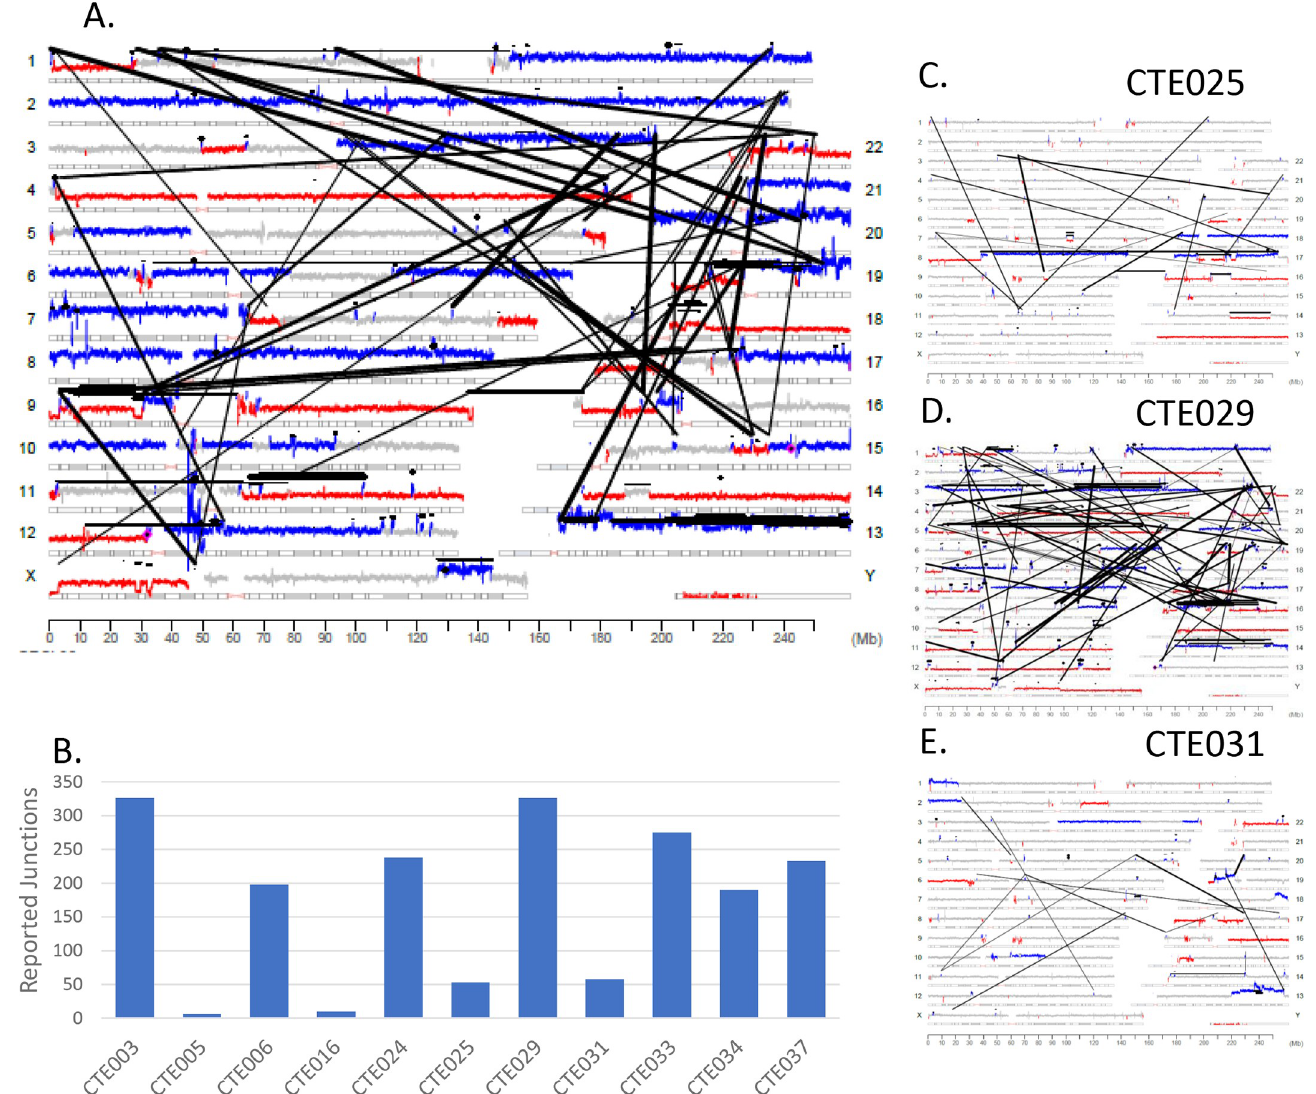
Fig 2. Mate–Pair sequencing results from primary tumor DNA. (A) Genome plot for primary tumor of case CTE024. Chromosomes are listed on the left and right Y–axis’; basepair position is on the X axis. Grey cytobands indicate genomic loci bands. The height of the dots each represents the average number of reads over 30 k bases. Grey color indicates wild–type 2 copy state of DNA, blue indicates gains, red indicates losses. Black dots indicate small intrachromosomal rearrangements, while the black lines indicate interchromosomal rearrangements or larger intrachromosomal junctions. (B) Bar graph showing the number of chromosomal junctions detected in the primary tumor of 11 cases with a threshold of at least 3 supporting reads per junction. (C) Genome plot for cases CTE025, (D) CTE029, and (E) CTE031.